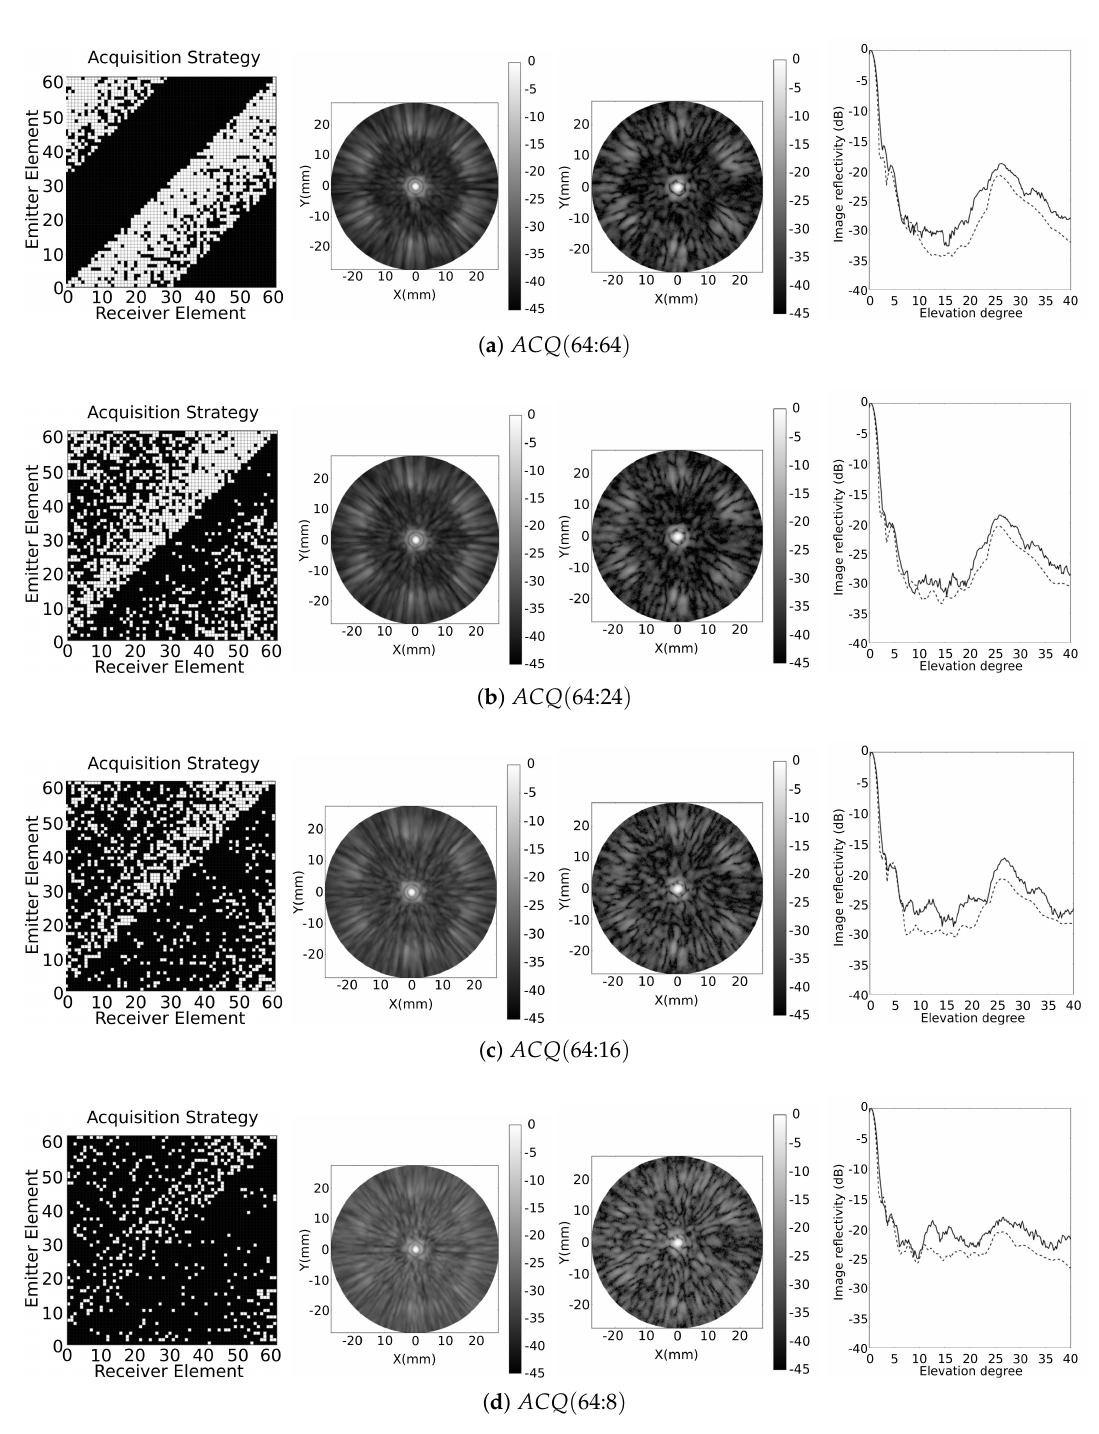
Figure 10. Results for the segmented annular array obtained from ACQ ( a ) ( 64:64 ) , ( b ) ( 64:24 ) , ( c ) ( 64:16 ) and ( d ) ( 64:8 ) , where the acquisition strategy, the simulated point reflector, the experimental metallic sphere image (cylindrical coordinates: Z = 40 mm R = [ 0:25 ] mm, θ = [ 0 ◦ : 360 ◦ ] ), and the image reflectivity (maximum at each elevation angle) are illustrated, respectively. For the image reflectivity, the simulated response is illustrated by a dashed line and the experimental result by a solid